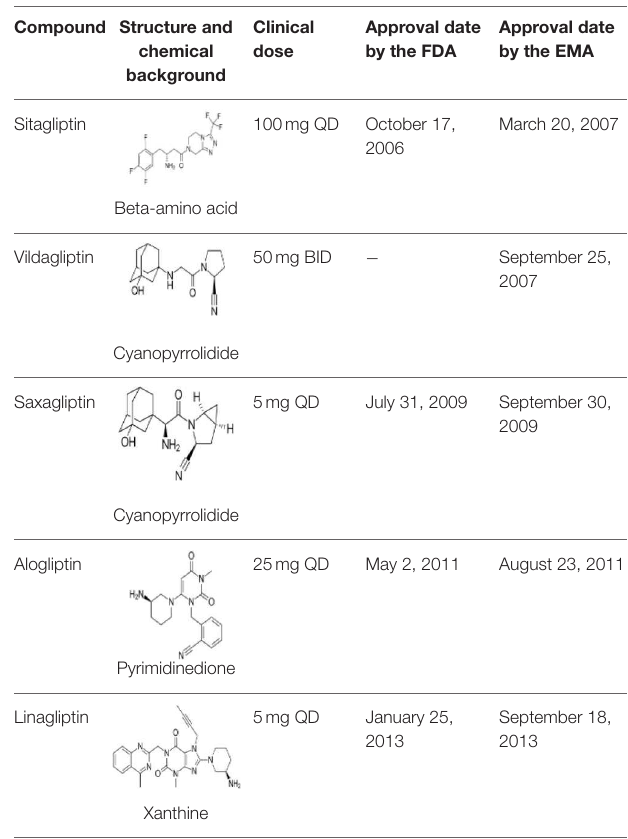
TABLE 1 | Structure, clinical dose (reflecting potency), and dates of approval by United States Food and Drug Administration (FDA) and European